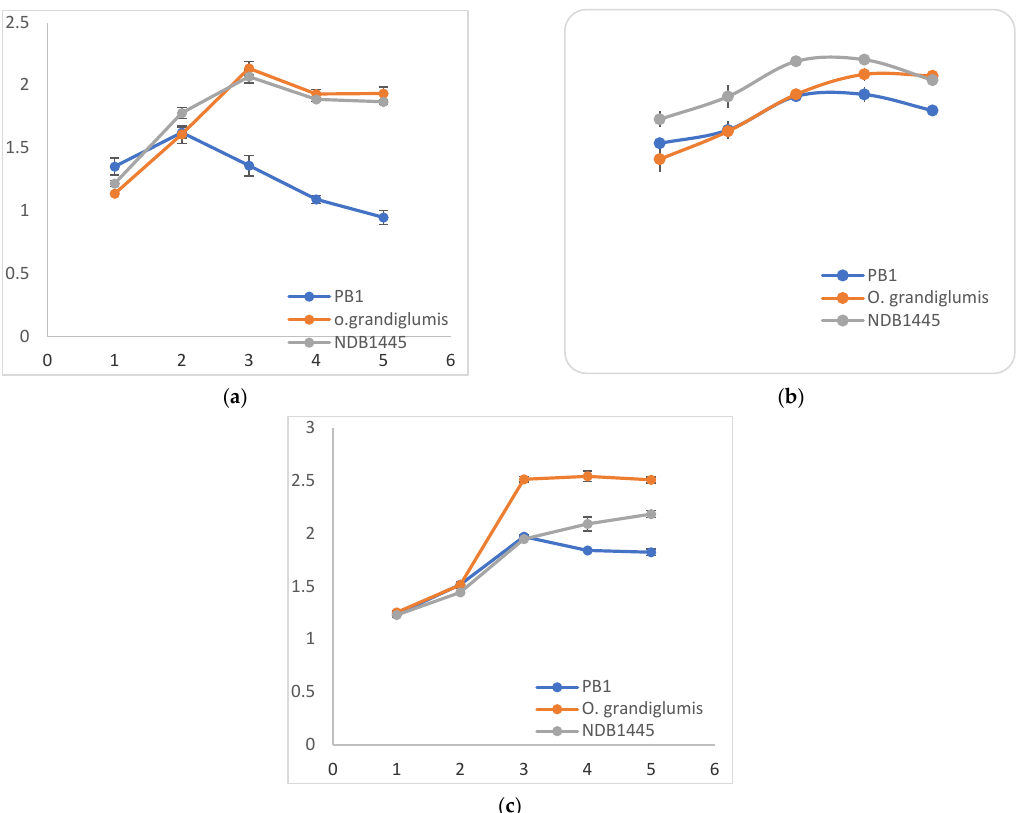
Figure 2. Enzymatic analysis of total phenol content, peroxidase (PO), and β‐ 1,3 ‐ glucanase in cultivated rice cv. Pusa Basmati ‐ 1, wild rice accession O. grandiglumis, and barley cv. NDB ‐ 1445 in control and R. solani infected samples at different time intervals (24 hpi [1], 48 hpi [2], 72 hpi [3], 96 hpi [4], and 120 hpi [5]). ( a ) Fold change in enzymatic activity of total phenol content. ( b ) Fold change in enzymatic activity of total peroxidase content. ( c ) Fold change in enzymatic activity of total β‐ 1,3 ‐ glucanase content. Mean differences were significant at ≤ 0.05% level. 3.2. R. solani Induced Proteome Shift in Cultivated Rice, Wild Rice, and Barley In the 2 ‐ DE maps, more than 1840 protein spots and an average of 613 protein spots were viewed with Coomassie brilliant blue staining across all the hosts. A total of 672 spots were identified, of which 605 were matched among the gels. In a comparison anal ‐ ysis between inoculated and non ‐ inoculated rice cv. Pusa Basmati ‐ 1, 67 spots were differ ‐ entially expressed on R. solani inoculated gel. After 48 hpi of inoculation, 15 distinct pro ‐ tein spots were found with significant differential accumulation in response to pathogen infection. Spots were considered to be differentially accumulated when a fold change of 2 in their relative volume was observed on all three experimental repeats (Figure 3a,b; Table 1). A total of eight up ‐ regulated and four down ‐ regulated protein spots were selected based on high percent reduction and induction of the protein for the MALDI ‐ TOF analysis (Figure 3c,d). The up ‐ regulated proteins were identified as ribulose bisphosphate carbox ‐ ylase large chain, thioredoxin peroxidase, alcohol dehydrogenase, fructose ‐ 1, 6 ‐ bisphos ‐ phatase, O ‐ methylthiopentene, OsClp1 ‐ putative protease homologue, thioredoxin, and hypothetical protein OsJNBa0069E14). The four down ‐ regulated proteins were identified as magnesium ‐ chelatase subunit chlI, alcohol dehydrogenase, catalase domain ‐ containing